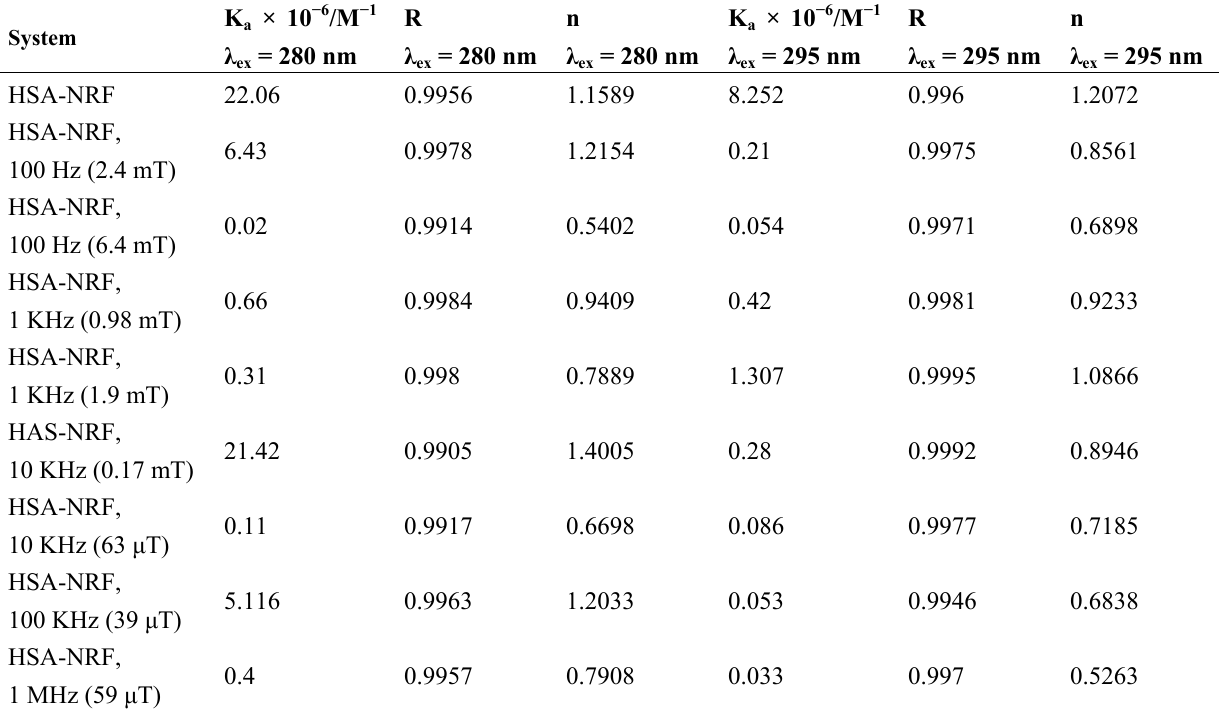
Table 2. Estimated values of the binding constant (Ka) and the possible number of binding sites (n) for binding of HSA with the NRF in the absence and presence of different EMFs at λ ex = 280 nm and λ ex = 295